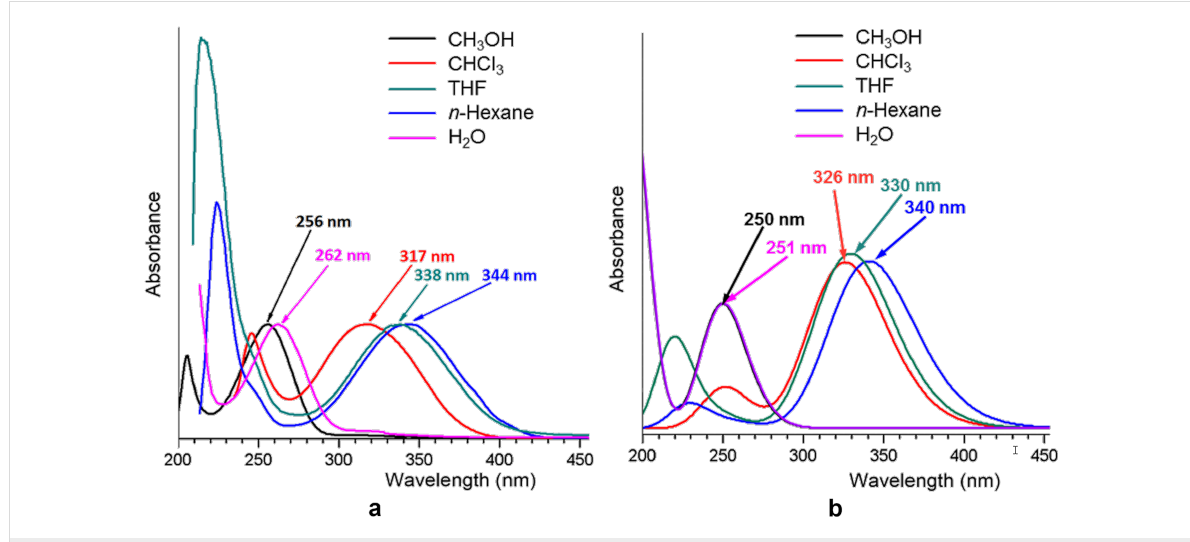
Figure 3: Experimental (a) and TD-tHCTHhyb/6-311+G(2d,p) calculated (b) UV–vis spectra of compound 8a in different solvents. The model struc- tures of 8a , shown in Figure 4 were used in the calculations.